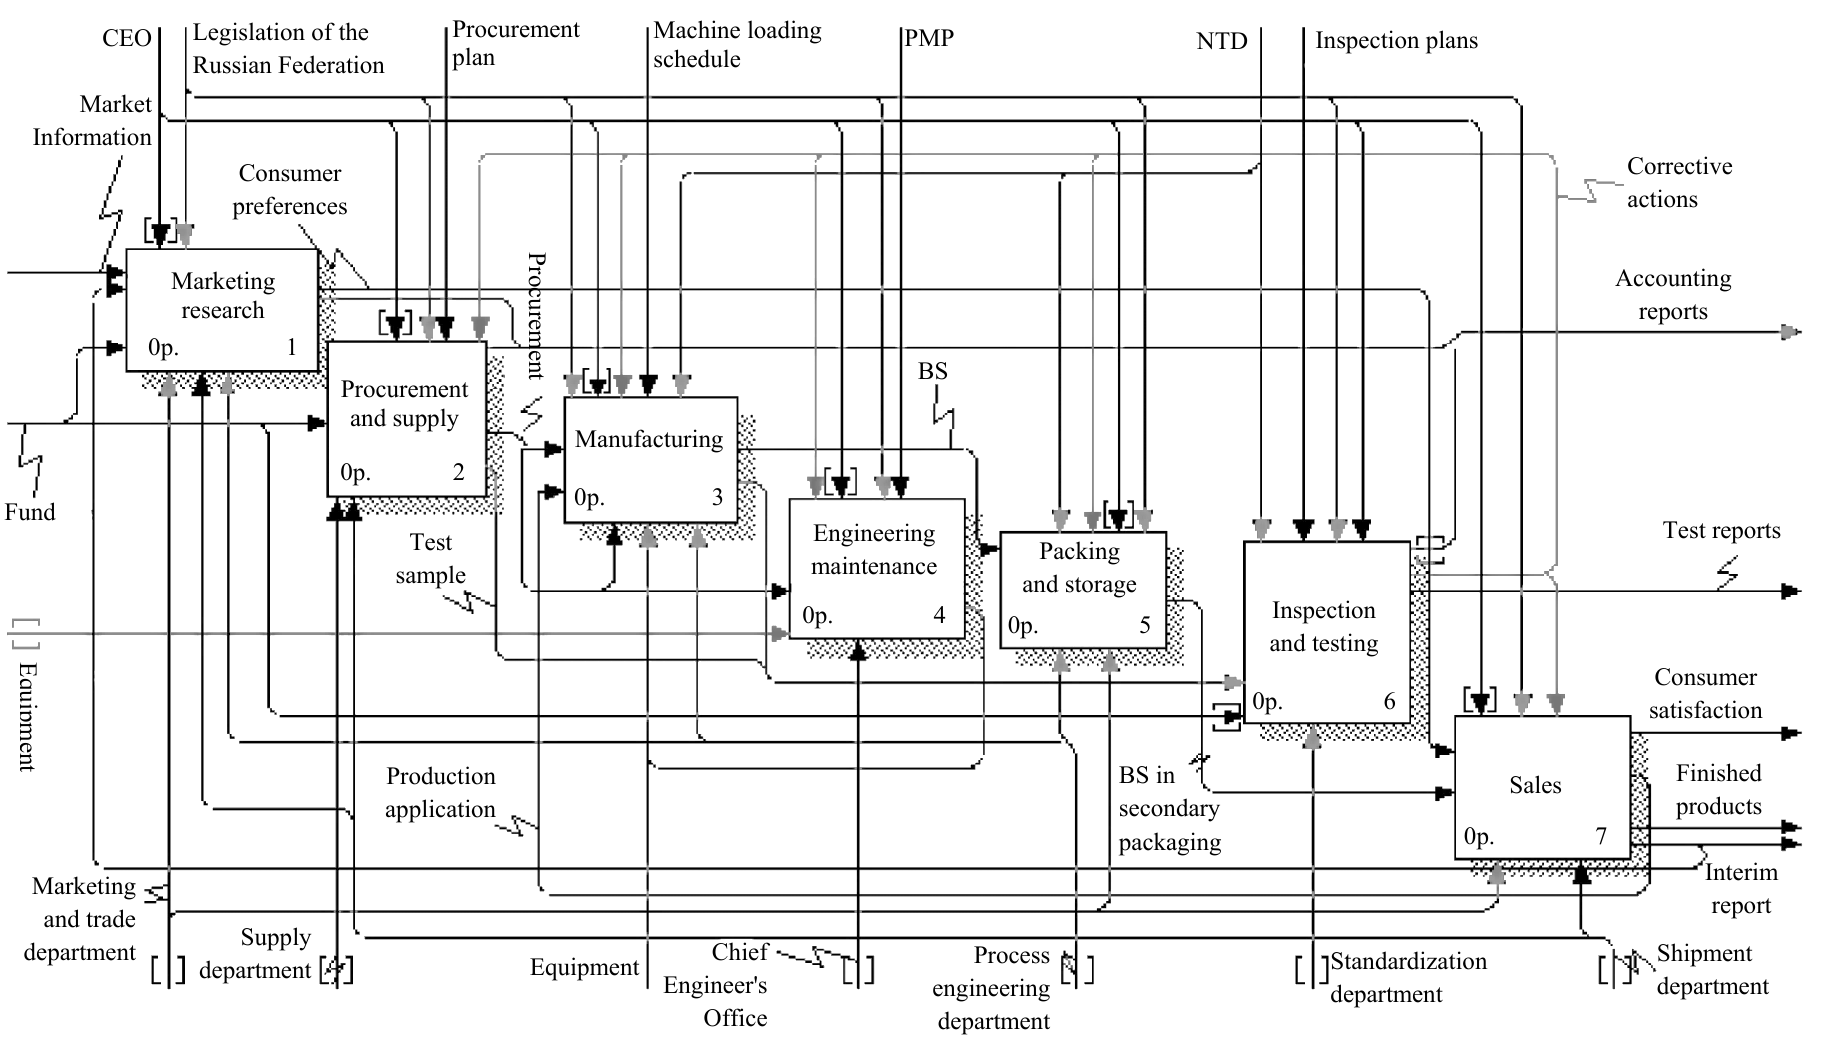
Fig. 2. Level A0 diagram "Activity for the production of cooked sausages": BS – boiled sausages, NTD – normative and technical documentation, PMP – preventive maintenance